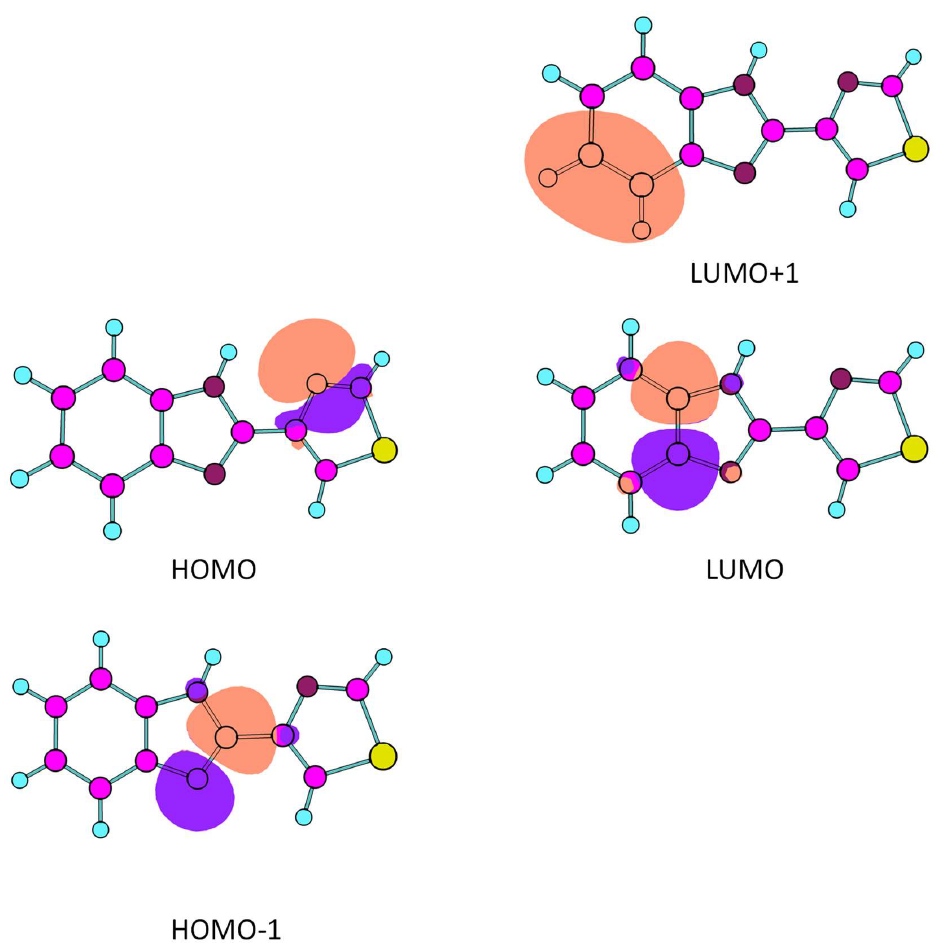
Figure 7. Most relevant calculated NBO orbitals for the interpretation of the for UV spectrum of thiabendazole (HOMO-1, HOMO, LUMO and LUMO+1 orbitals).